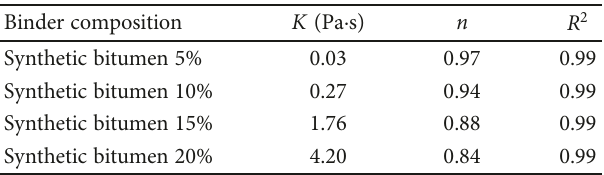
Figure 5: Stress versus shear rate for synthetic bitumens. Table 3: Linear regression parameters for the Ostwald-de-Waele model.